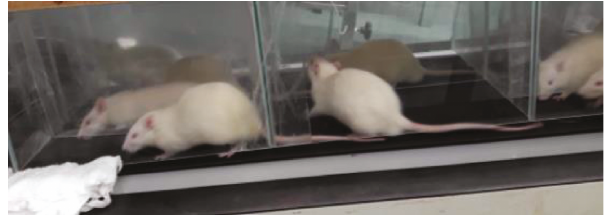
Figure 1: Animals performing eccentric